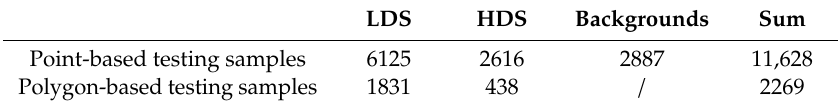
Table 1. The number of testing samples.